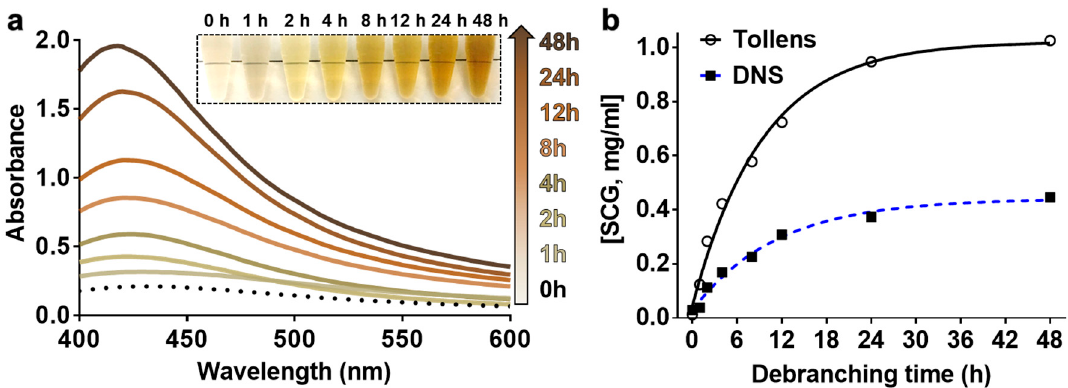
Figure 6. ( a ) UV-vis absorption spectra of reactions at a given time point for 48 h. The reaction was carried out with 1 mg of waxy maize starch and 1 APSU/mL of pullulanase at 37 °C. Inset shows the reaction tube at each time point. ( b ) A plot of SCG concentration versus debranching time measured by modified Tollens’ reaction (hollow round) and DNS assay (filled square). The concentration of SCG was estimated based on the calibration curve obtained by modified Tollens’ reaction and DNS assay, respectively.